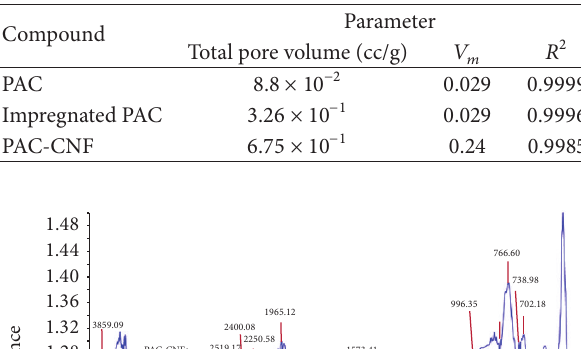
Table 2: BET isotherm parameters for nitrogen gas adsorption by PAC and PAC-CNF.